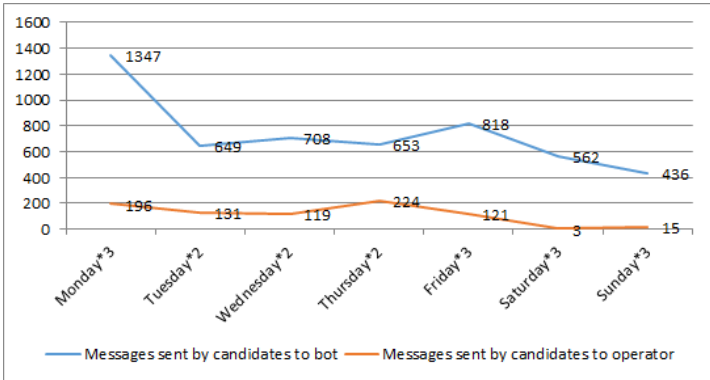
Figure 12. Messages sent by candidates to the bot and operators.